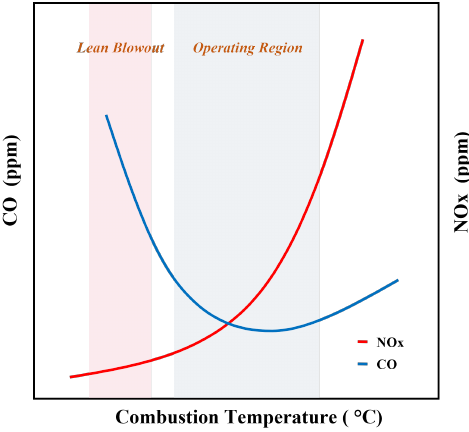
Figure 1. Illustration of the DLE gas turbine’s operating range